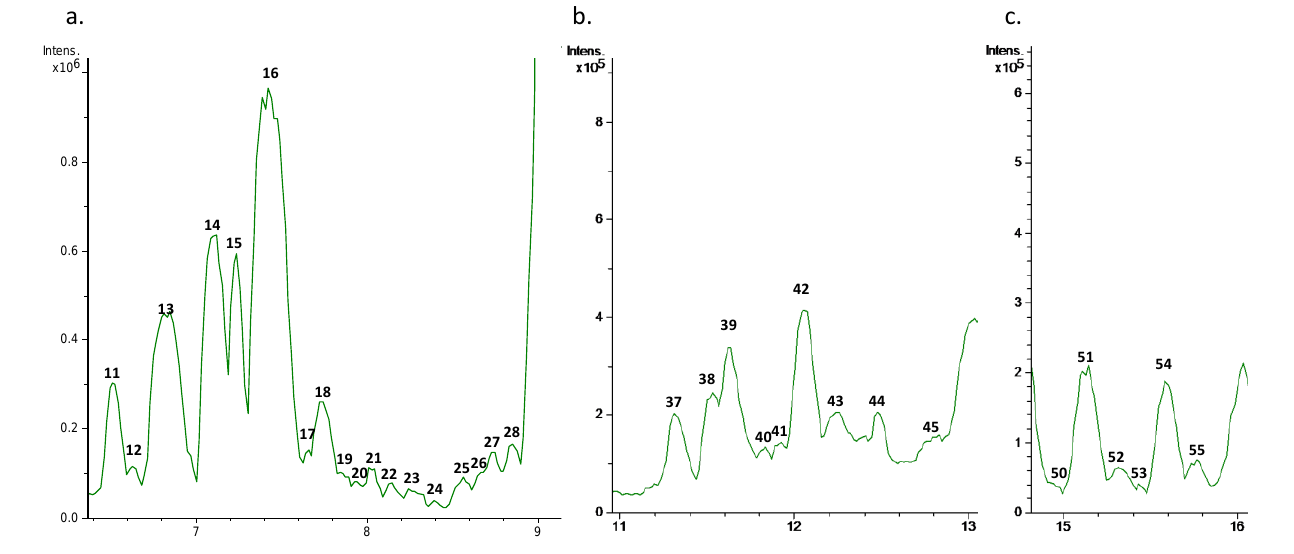
Figure 1. Base peak chromatogram (BPC, 50–1000 m / z ) of the olive leaf extract, indicating zoomed zones ( a – c ). Table 1. Identified compounds in olive leaf